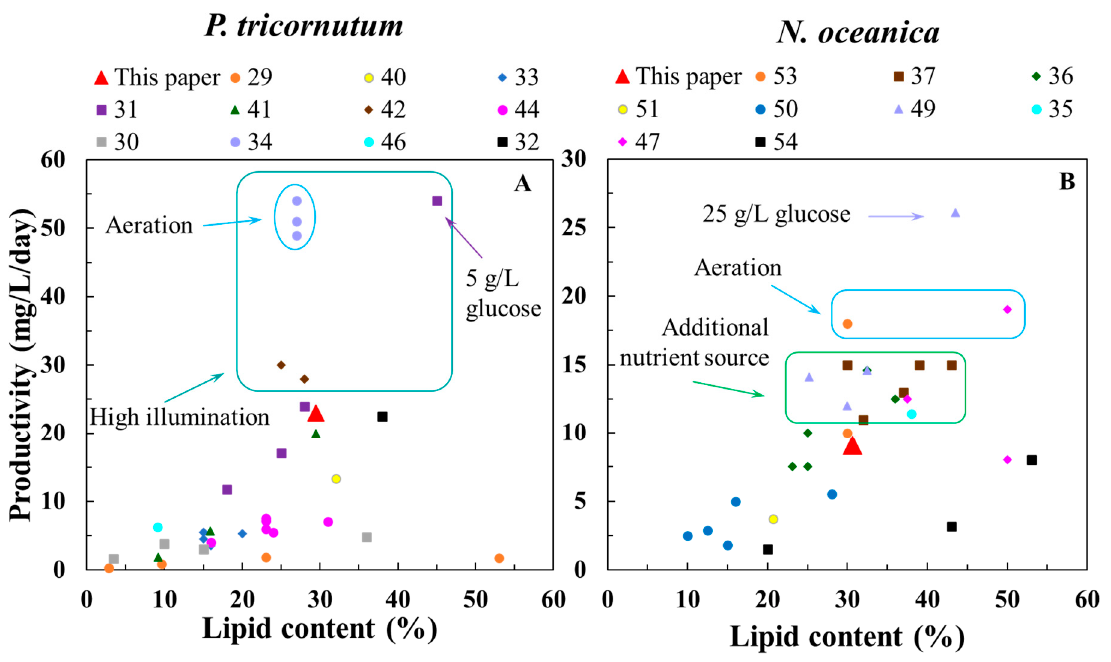
Figure 5. Comparison of the lipid content and lipid production performances of ( A ) P. tricornutum and ( B ) N. oceanica cultured in S-MSGR with other results from the literature. The legend indicates the references for the data.